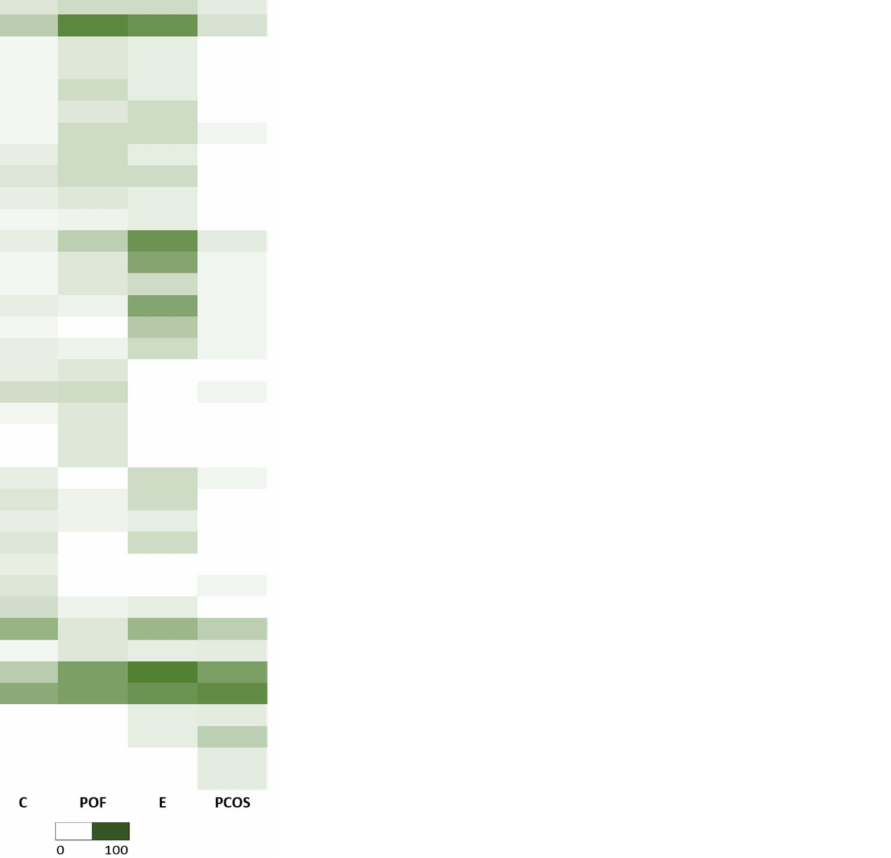
(49) ethyl xylene; (55) tetracosamethyl-cyclododecasiloxane; (56) docosane; (57) hexamethyldisiloxane; (58) 1,3-di-tert-butylbenzene; (60) 1-dodecanol; (67) oleamide; (71)